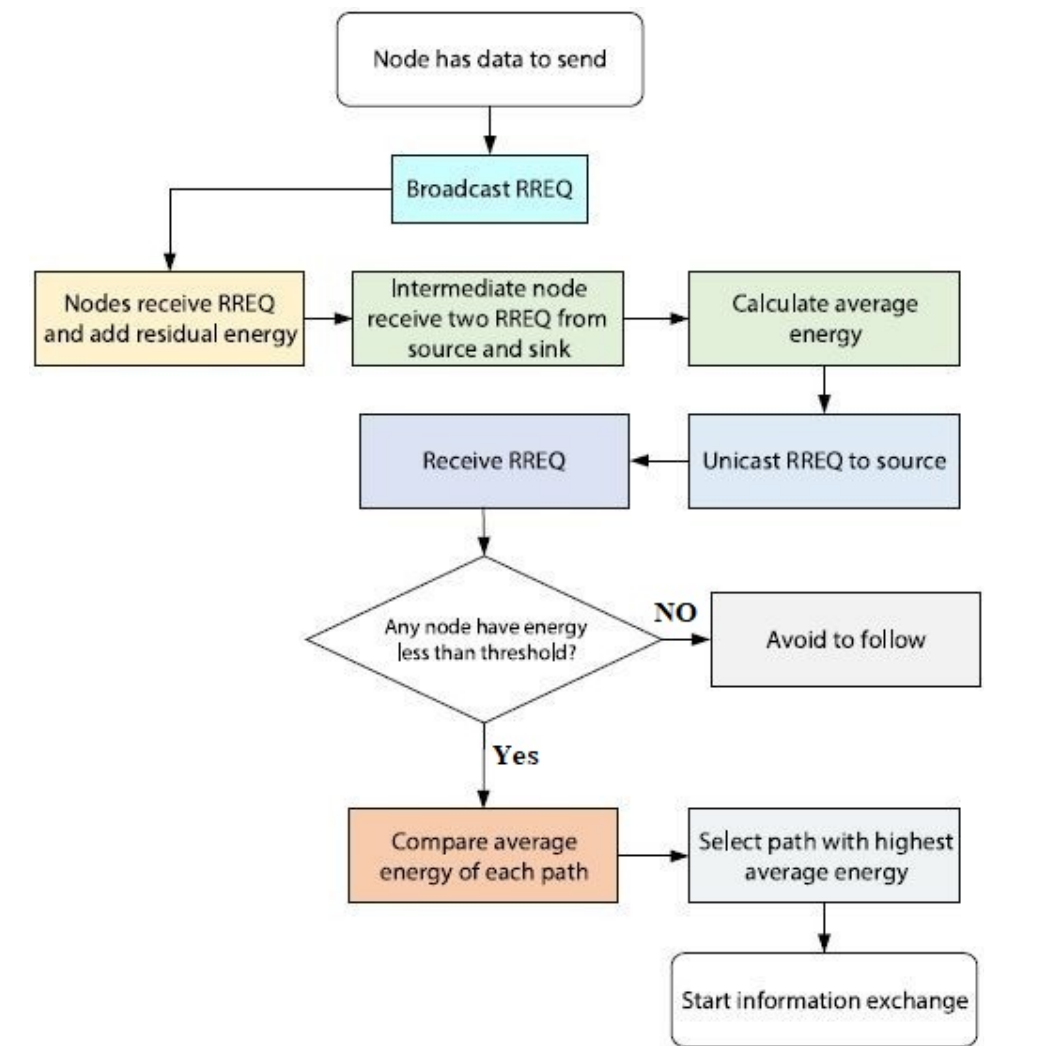
Figure 2. System diagram of path selection.